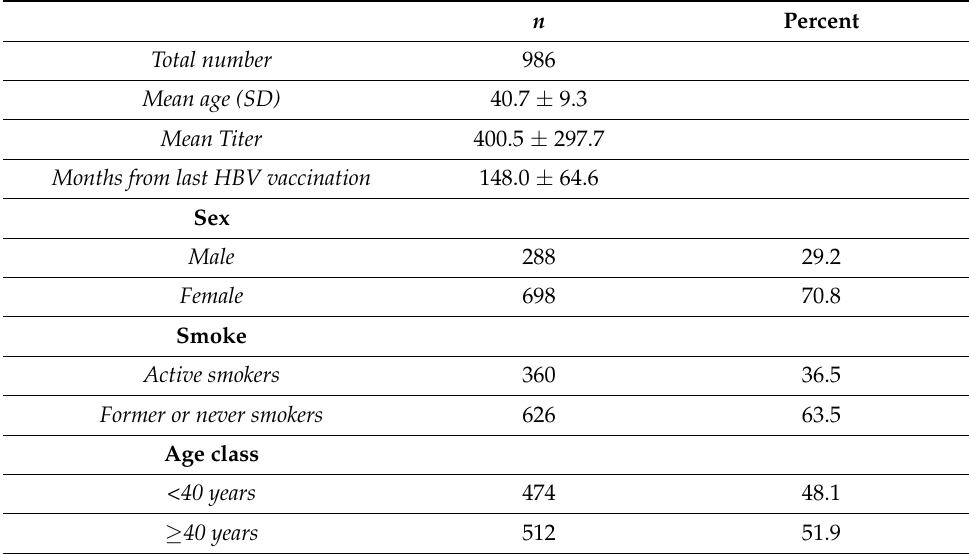
Table 1. General characteristics of study